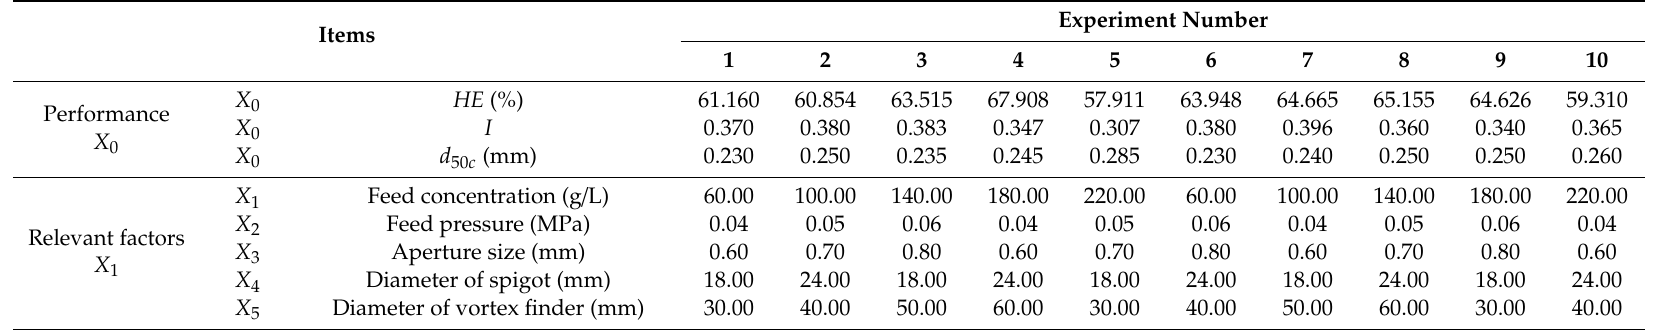
Table 4. Performance evaluation under di ff erent relevant factors for